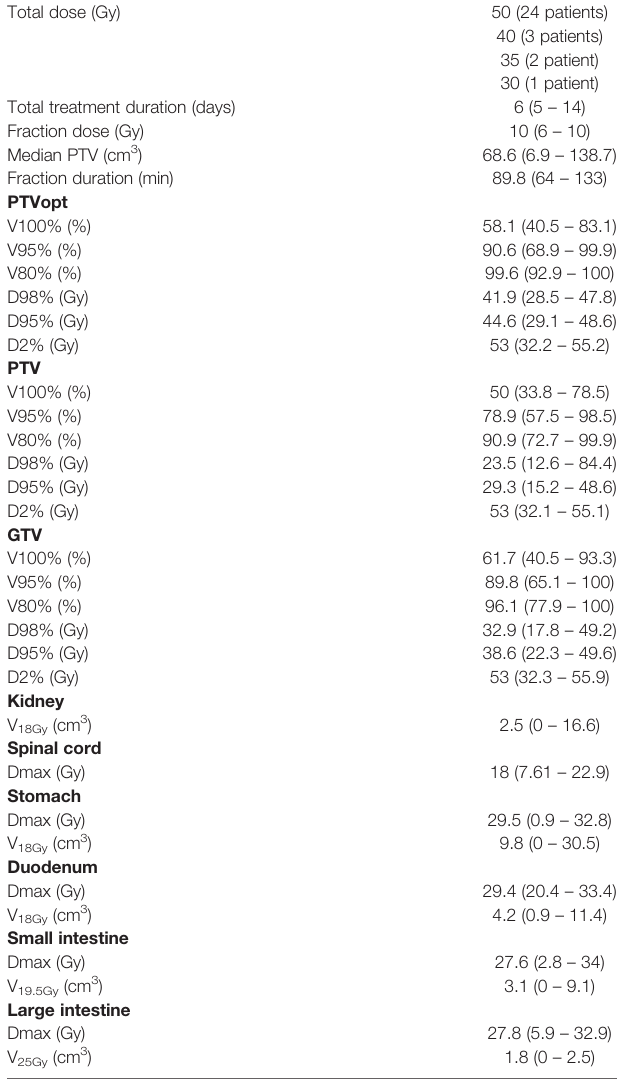
TABLE 3 | Median (min – max) dosimetric data for initial